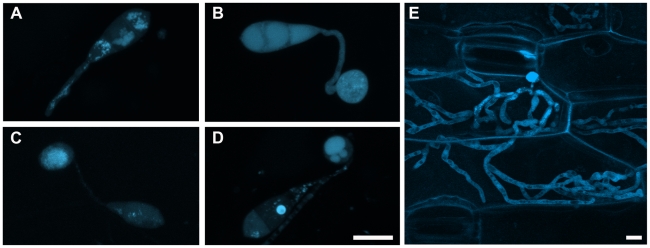
MoHYR1 changed localization during pre-penetration events on the
surface of a leaf.The MoHYR1 coding sequence was fused to the cerulean fluorescent protein
to study protein localization during early infection. (A)
HYR1 at 1 hpi with putative vacuole location and low level cytoplasmic
distribution; the germ tubes has formed, but no appressorium.
(B) HYR1 at 6 hpi with increased cytoplasmic
localization where it is likely to be required to function in ROS
scavenging; an immature appressorium was apparent. (C) HYR1
at 12 hpi with cytoplasmic location; a mature appressorium was apparent.
(D) HYR1 at 24 hpi with vacuole and low level
cytoplasmic localization in the appressorium. (E) HYR1 at
72 hpi again showing cytoplasmic localization. Images were taken with
confocal microscopy and all experiments were done on the surface of
barley leaves. Scale bar shown  = 10 µm for
all images.